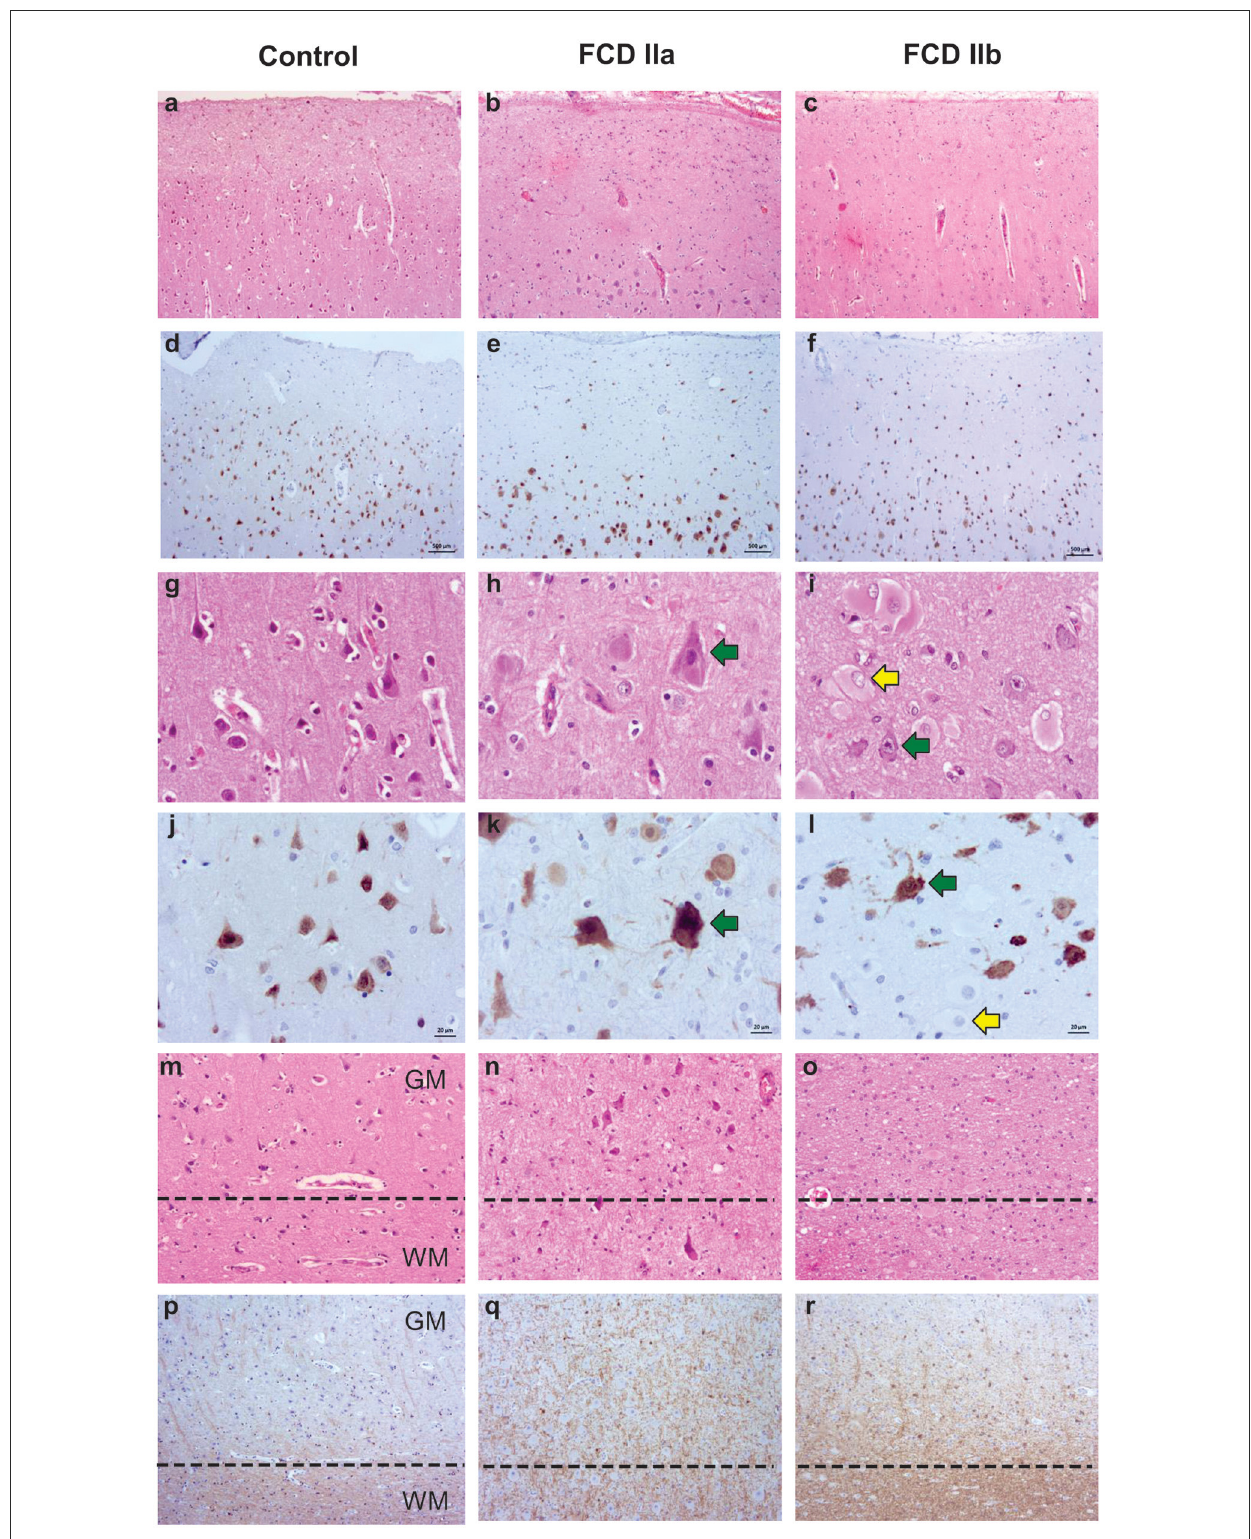
FIGURE2 Representative histopathological and immunostaining features of autopsy (control), focal cortical dysplasia (FCD) ILAE type IIa (FCD IIa) and FCD ILAE type IIb (FCD IIb) samples. Hematoxylin and eosin staining (a–c, g–i, m–o) . Immunohistochemistry for NeuN (d–f, j–l) or CNPase (p–r) . Cortical cytoarchitectural features, that is, layering and neuronal size and orientation, are preserved in controls (a, d, g, j, m) specimens. However, dyslamination (b, c, e, f, h, i, k, l, n, o) and dysmorphic neurons [green arrows in (h, i, k, l) ] without and with balloon cells [yellow arrows in (i, l) ] are observed in FCD IIa and FCD IIb, respectively. Gray matter (GM) and white matter (WM) boundary [dotted line in (m–o) and (p–r) ] is preserved in control samples (m, p) and blurred in FCD IIa (n, q) and FCD IIb (o, r) . Scale bars: 500 µ m (a–f) , 20 µ m (g–l) , and 50 µ m (m–r)